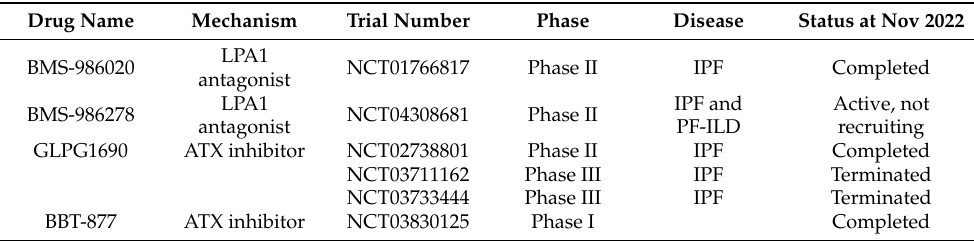
Table 1. Clinical trials on the LPA pathway for IPF. Clinical studies on LPA pathways related to IPF (revealed by search via the U.S. National Library of Medicine,